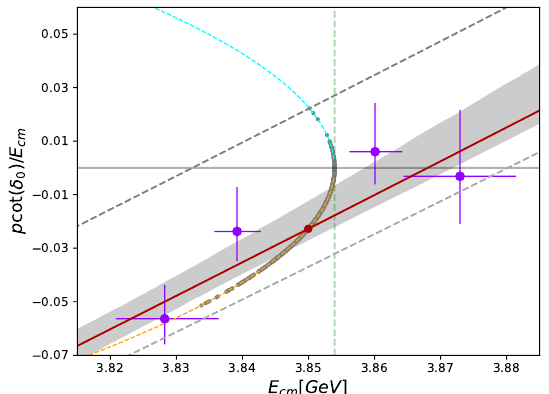
Figure 12 . Pole distribution [gray filled circles] along the (virtual) bound state constraints [(cyan) orange dashed curve] in the elastic D ¯ D scattering. The energy levels [violet filled circles] considered in the fit and the fit results [red solid line and the gray band] are also shown. The two gray dashed lines represent the two extreme cases, one with the virtual bound state and one with no poles on the real